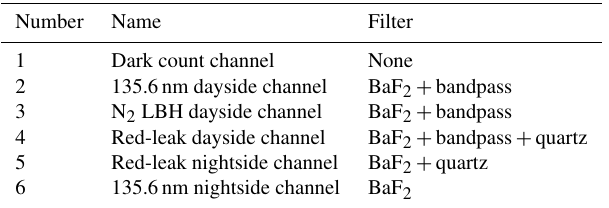
Table 2. Channel information.